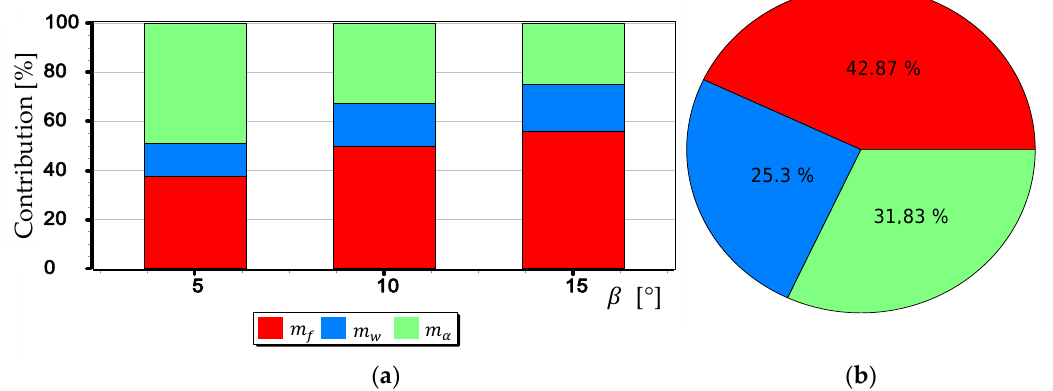
Figure 29. Percentage contribution for DIJ FC350 camera: ( a ) Calculated for 𝛽 equals 5°,10° and 15° ; ( b ) Calculated as a mean value.